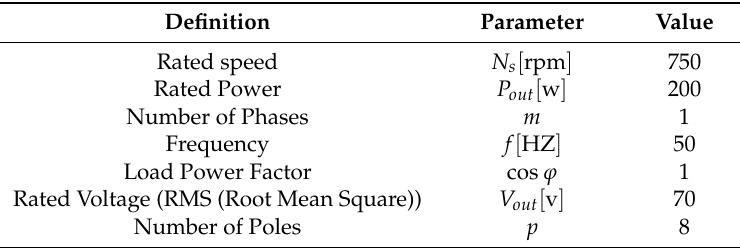
Table 2. The main design parameters.